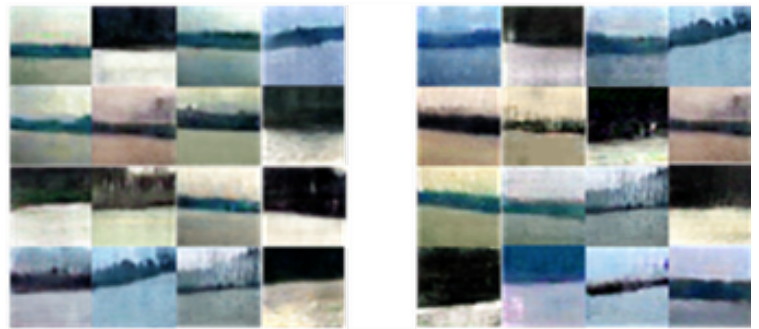
Figure 4. Two groups of instances generated from original manual samples by WLgenerateNet (here, r = 64 and s =